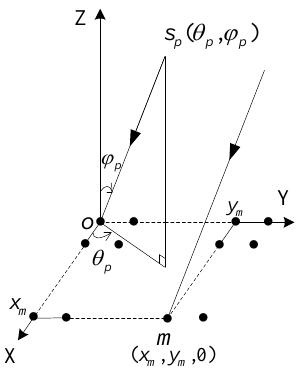
Figure 1. The coordinate system.